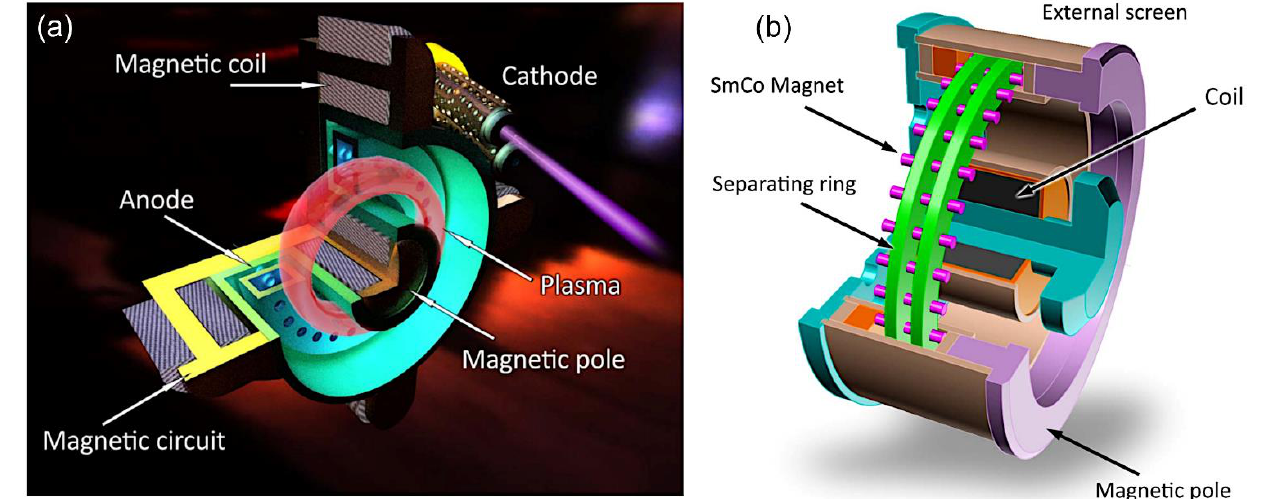
Figure 9. ( a ). Magnetic circuit (shown in yellow) in the typical Hall-type thruster. ( b ) Hybrid mag- netic system of a small Hall thruster, which incorporates coils that can be connected in the straight and reverse directions, and a set of 24 to 50 samarium – cobalt permanent magnets. The permanent magnets are necessary for principal magnetization, while the turns ensure flexible control of the resulting magnetic field. Reproduced with permission from Ref. [123]. Copyright 2018, IEEE.